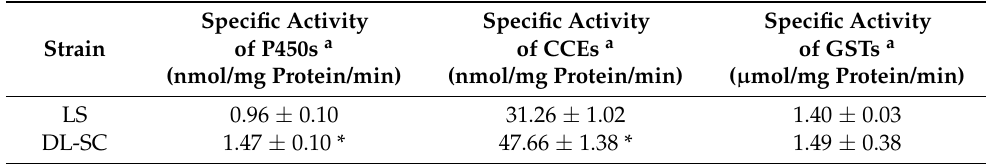
Table 2. Detoxifying enzyme activities in the susceptible and resistant P. citri strains.